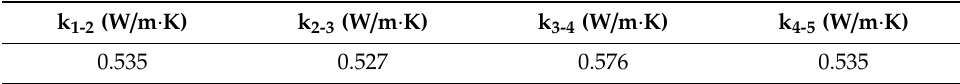
Table 9. Thermal conductivities of the surrounding material obtained from the measurement of sensors